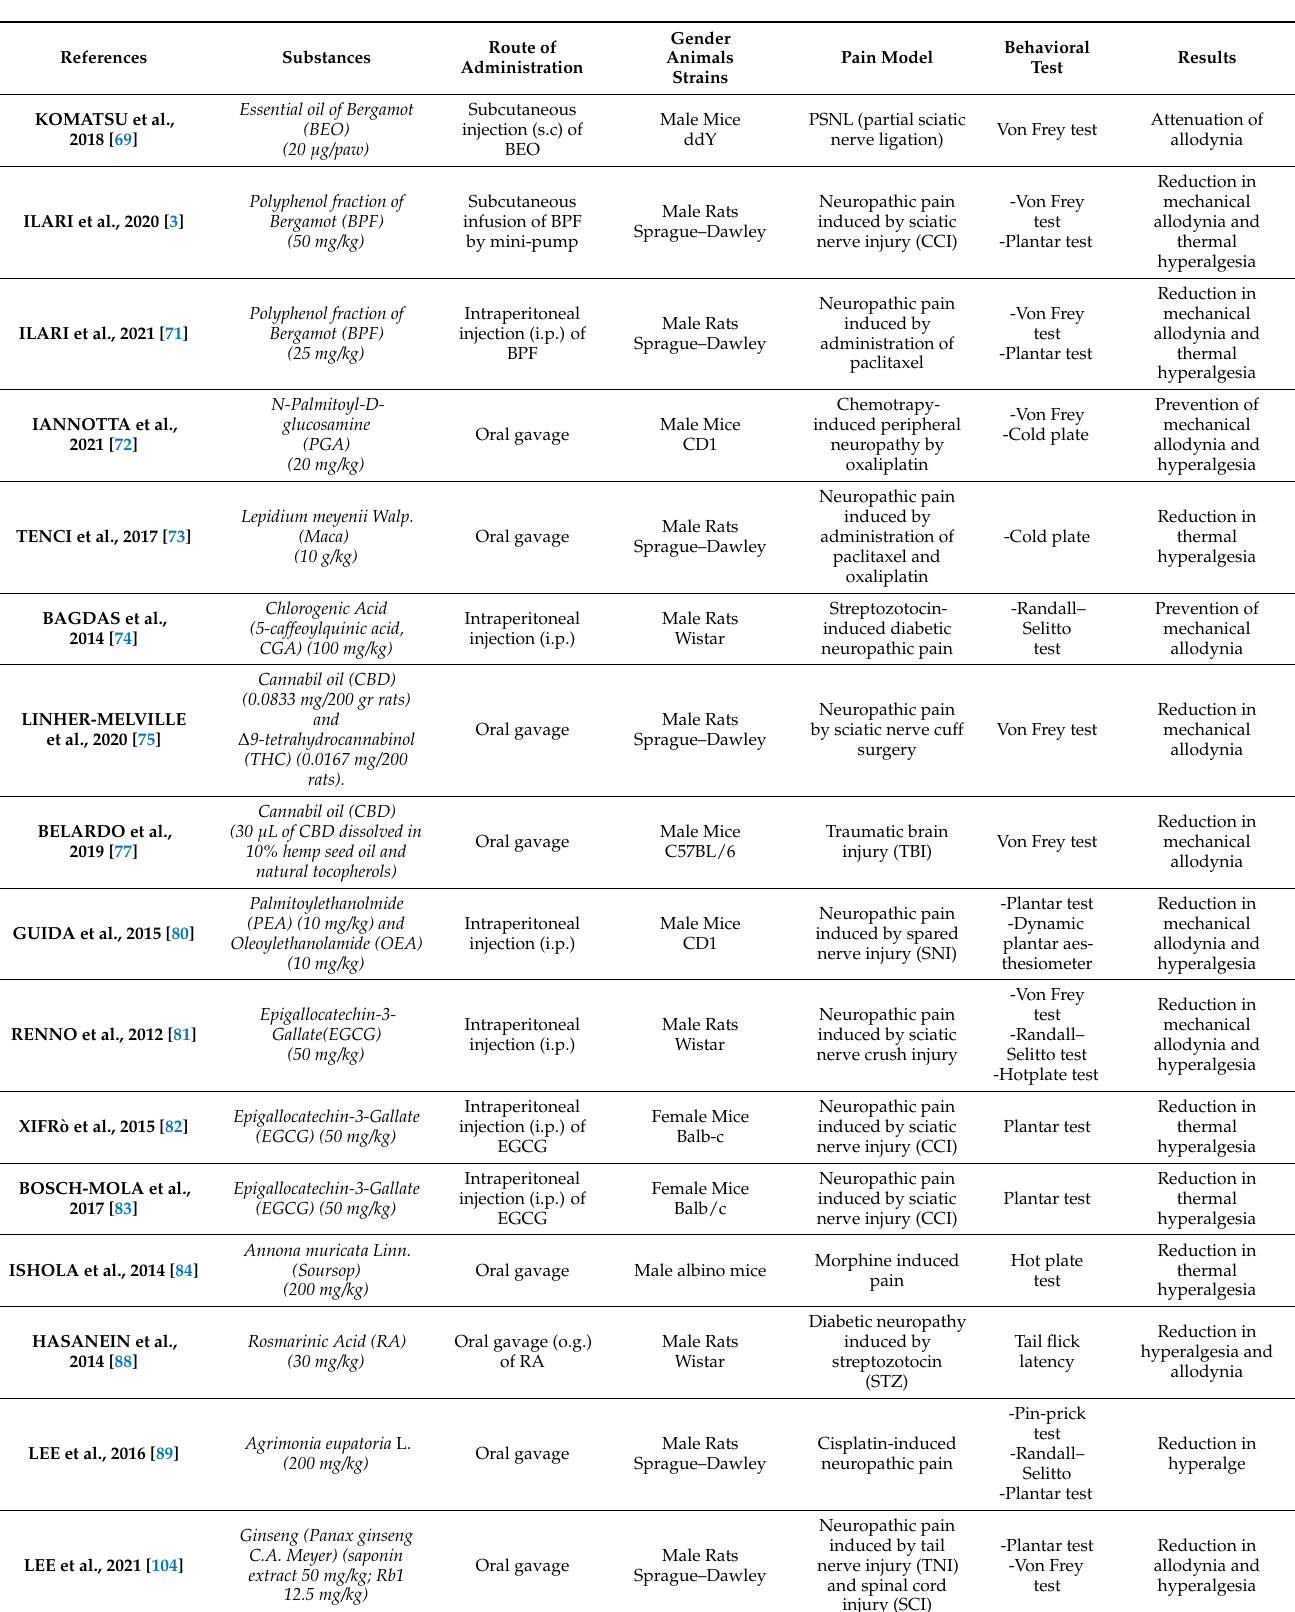
Table 3. Studies on natural products effects in several model of neuropathic